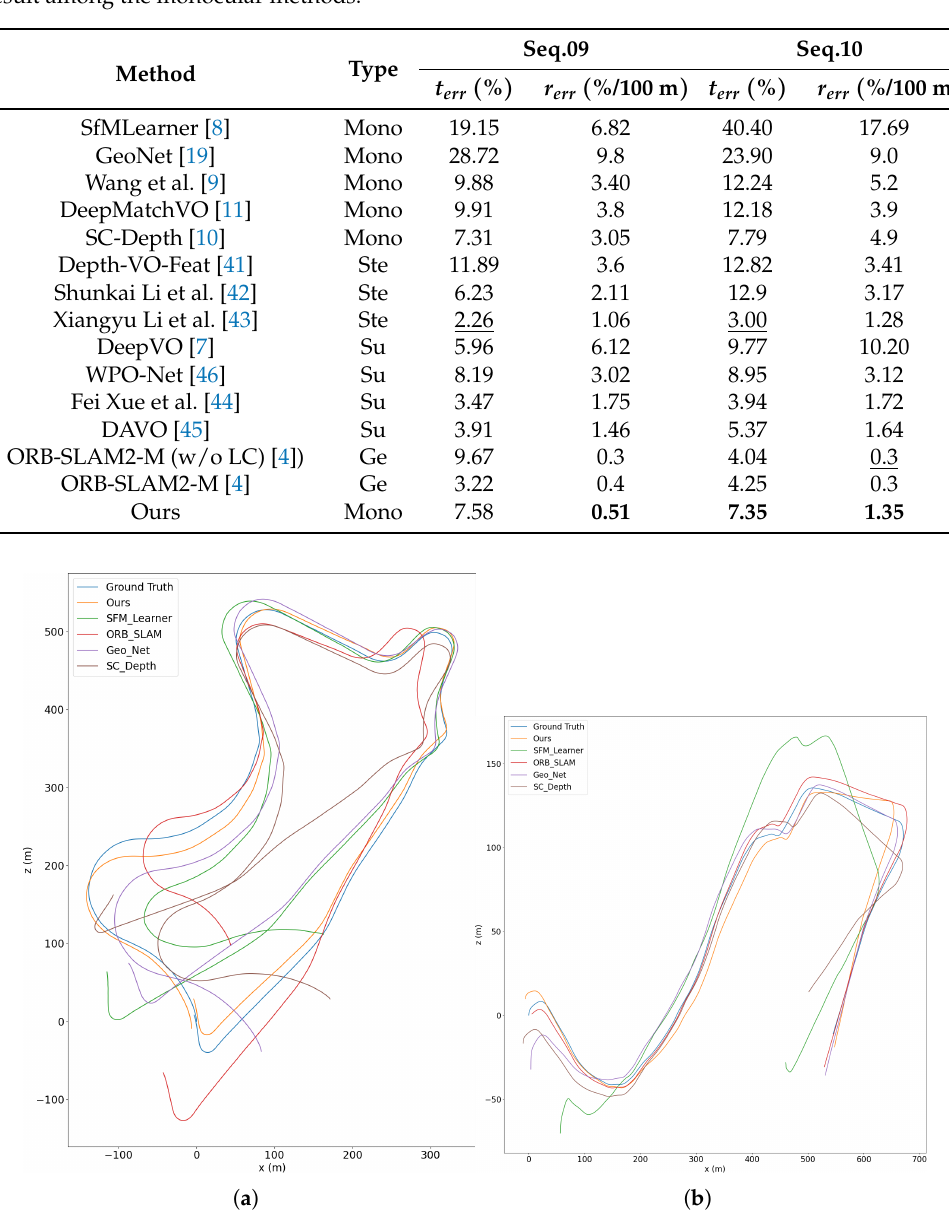
Table 1. Visual odometry results on KITTI dataset. Mono/Ste stands for training on monocular/stereo videos, Su stands for supervised learning method, and Ge stands for model-based method. The underline represents the best result among all types of methods, and the boldface represents the best result among the monocular methods.